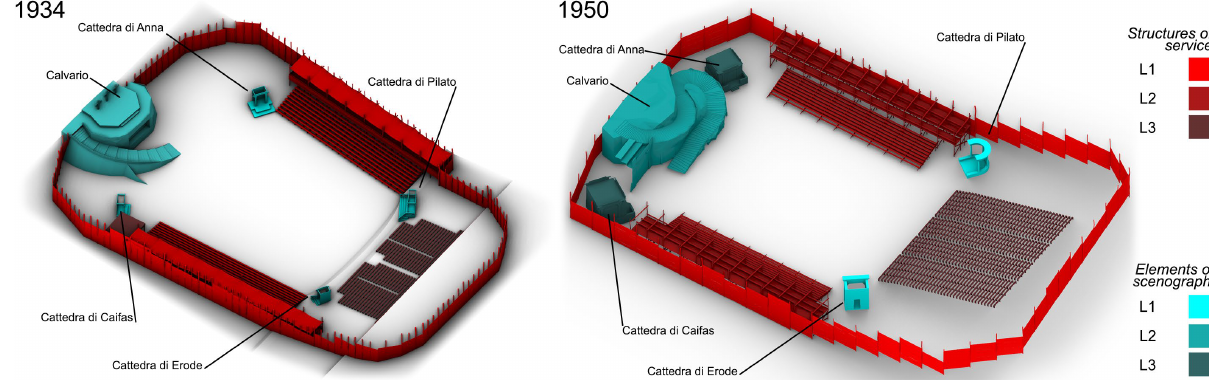
Figure 7 . Synthetic model of the elements constructed for the Passion play (1935 and 1950) . © A.